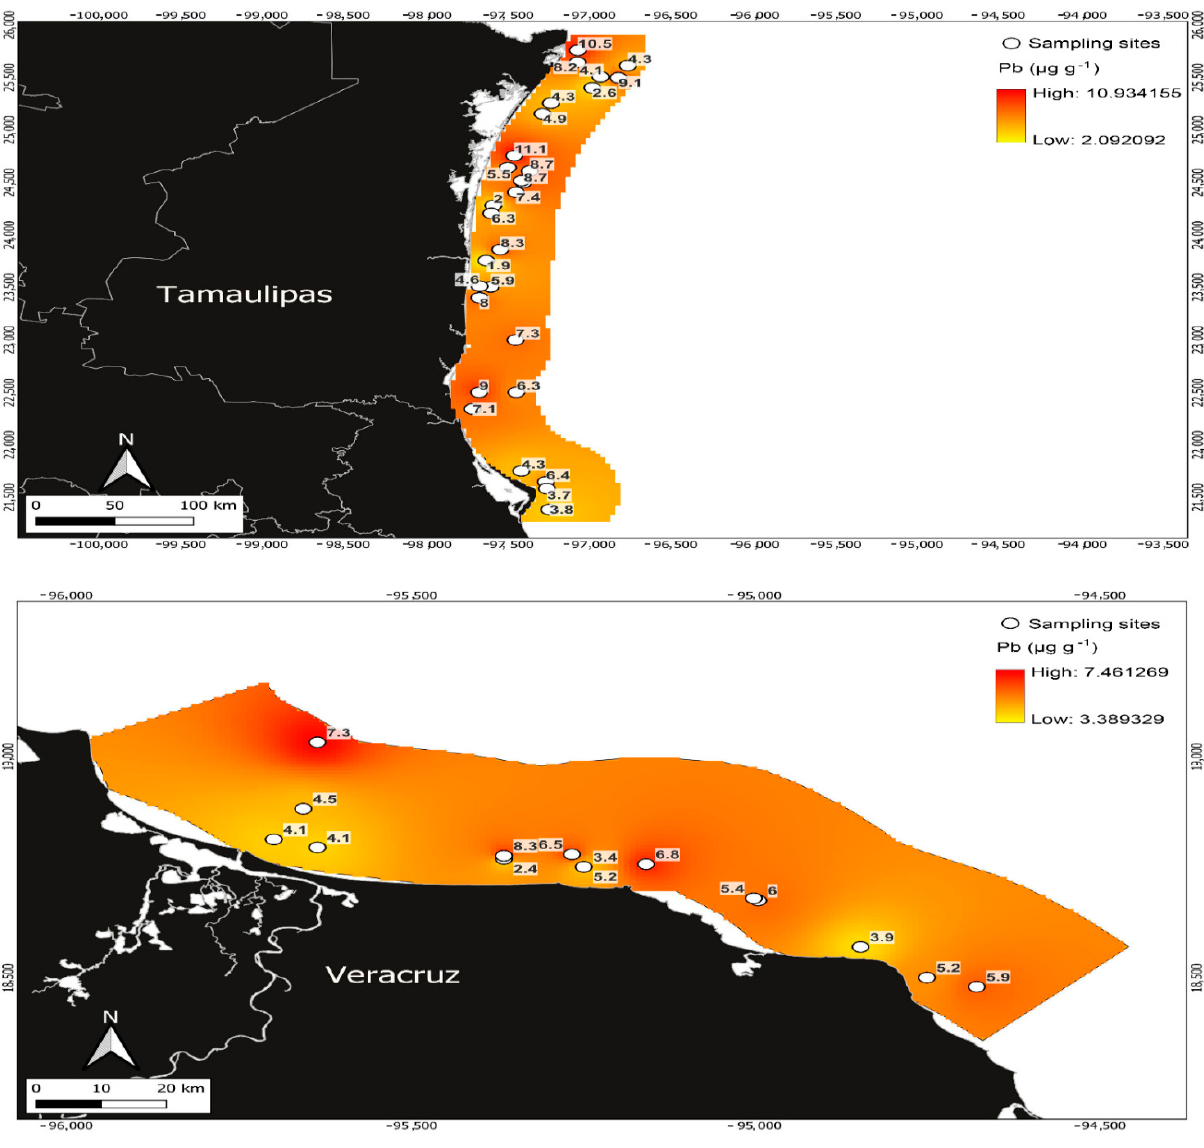
Figure 3. Pb concentrations in Penaeus aztecus shrimp (whole body) in the areas of Tamaulipas ( upper ) and Veracruz ( below ), Mexico.